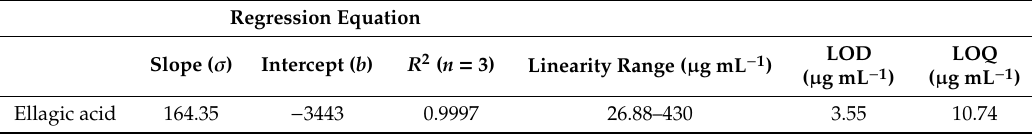
Table 2. Results of linear regression equation analysis, LOD a and LOQ b for ellagic acid. Regression